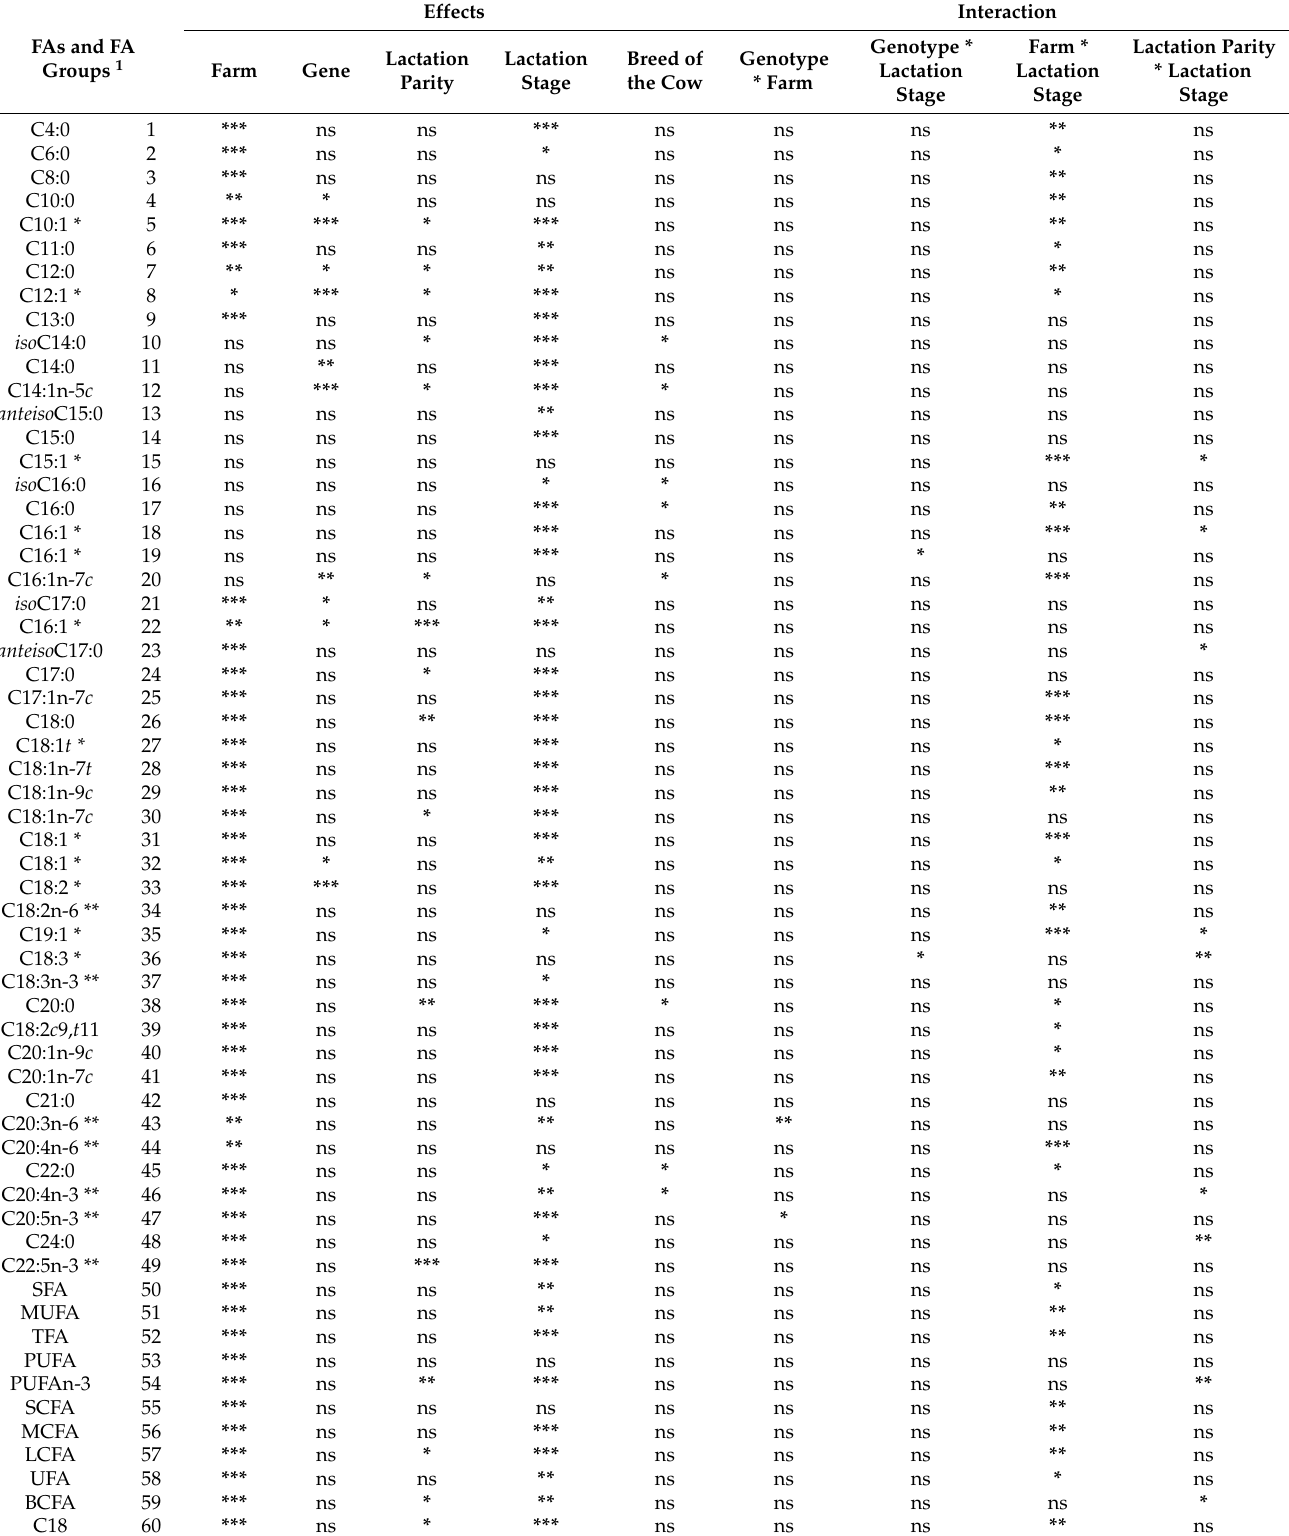
Table 7. Effects on the fatty acid (FA) proportions ( p- values)— SCD1